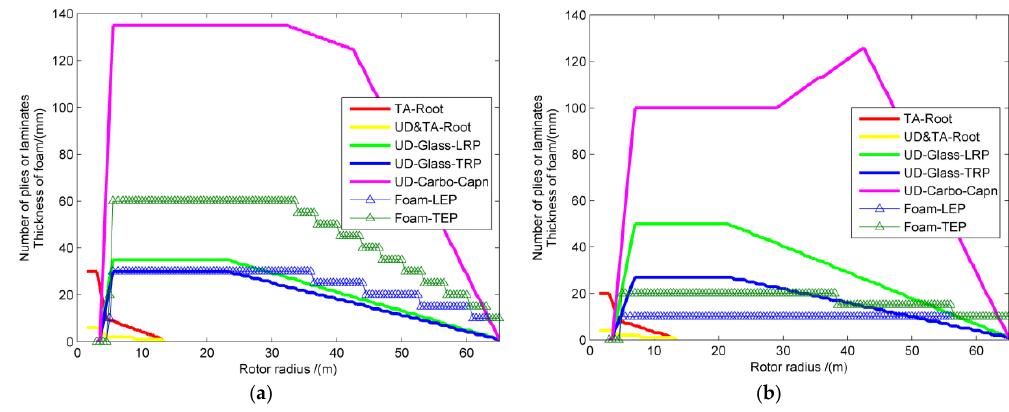
Figure 13. Optimization process converging to a minimum blade mass of 15,684 kg.